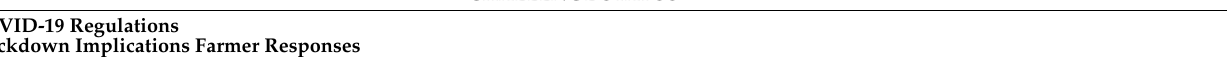
Table 1. Farmer challenges encountered during lockdown regulations enforcements ( n =